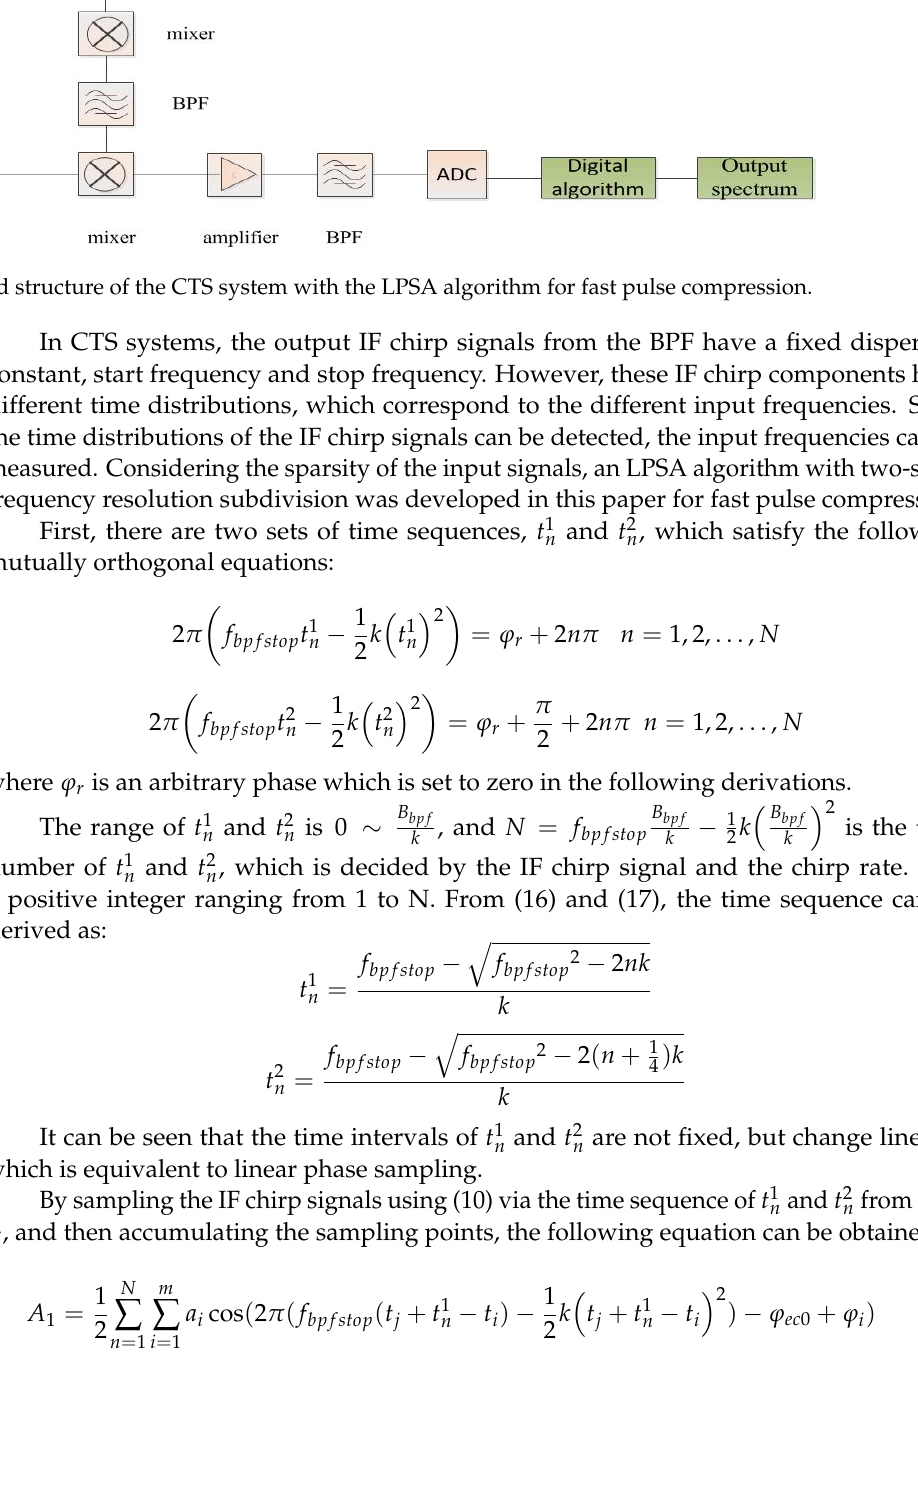
Figure 2 is a brief schematic diagram of a CTS system with the LPSA method for pulse compression. Only one channel is exhibited for signal expansion and compression in the system. The input signals are first mixed with the chirp signal to obtain the modulated chirp signals carrying the information of the input signal. After the amplifier and the band-pass filter, the output IF chirp signals are sampled and compressed into pulses by the digital algorithm.